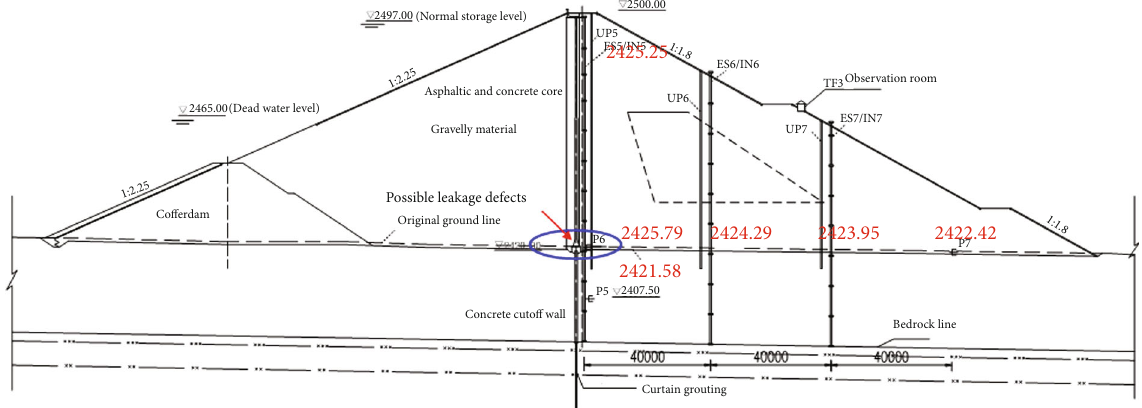
Figure 18: The distribution map of water level in the cross section 0 + 540